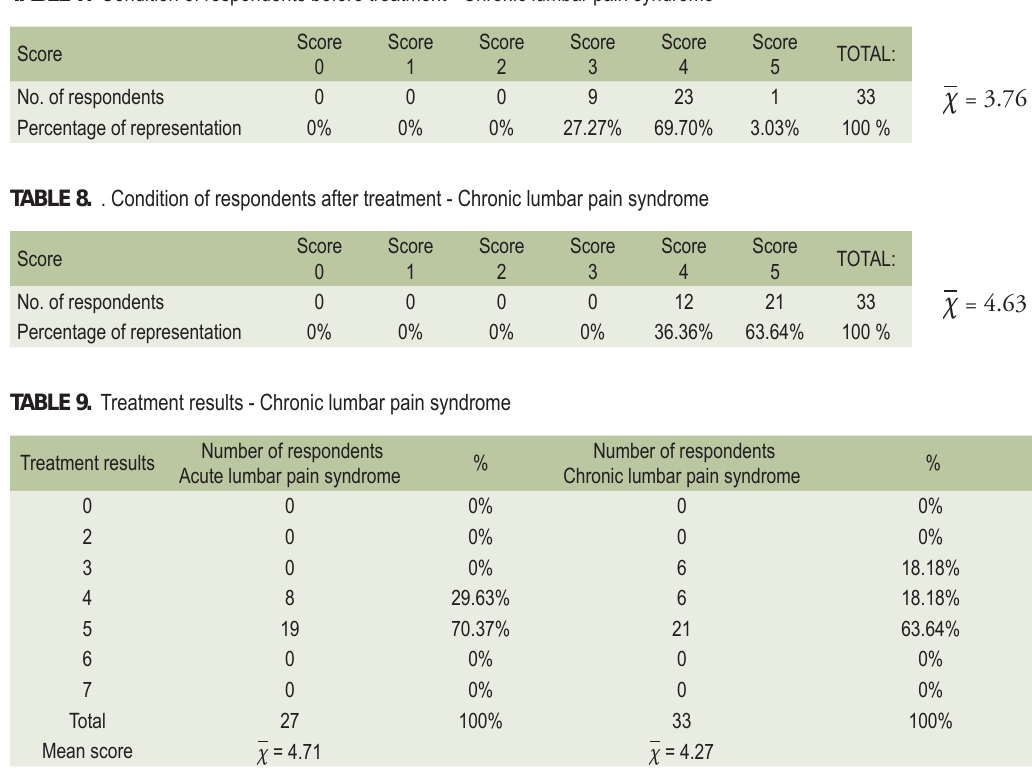
TABLE 7. Condition of respondents before treatment - Chronic lumbar pain syndrome